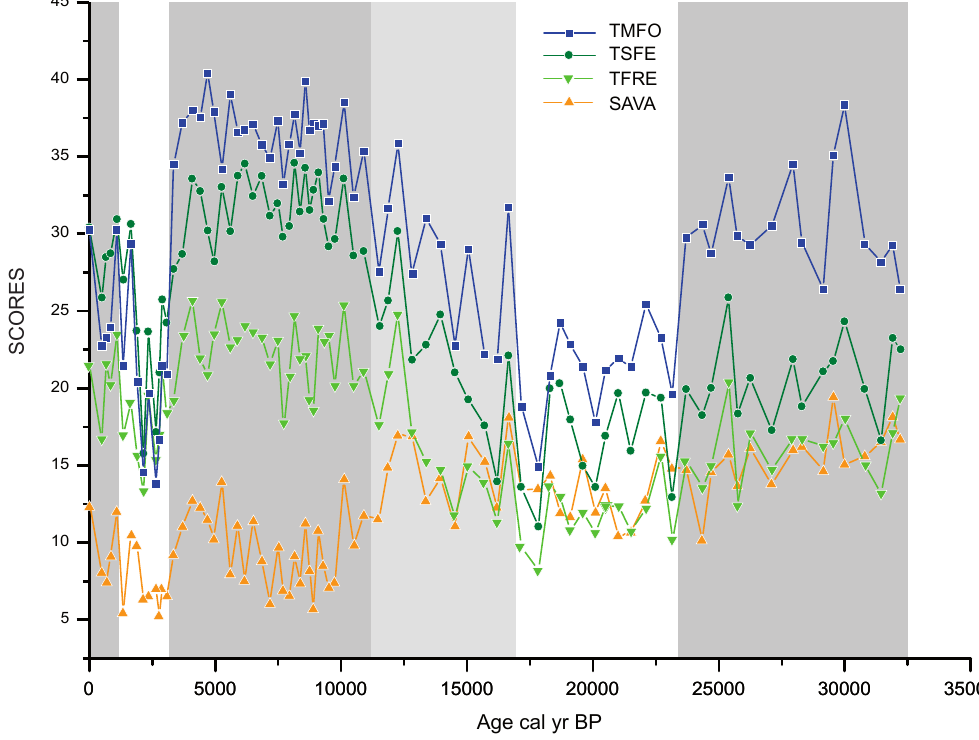
Fig. 5. Reconstructed successional stages along the Barombi Mbo pollen sequence. TMFO (Tropical Mature FOrest), TSFE (Tropical Secondary ForEst), SAVA (SAVAnna), TFRE (Tropical Forest